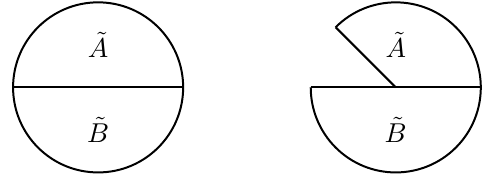
Figure 6 . The disk perpendicular to the horizon, which pierces the center of the disk. Left: here, parts ~ A and ~ B in spacetime are respectively formed by rotating both spatial subregions A and B by (cid:6) (cid:25) . Right: the graphical representation of (cid:26) A , with a wedge missing in spacetime subregion A